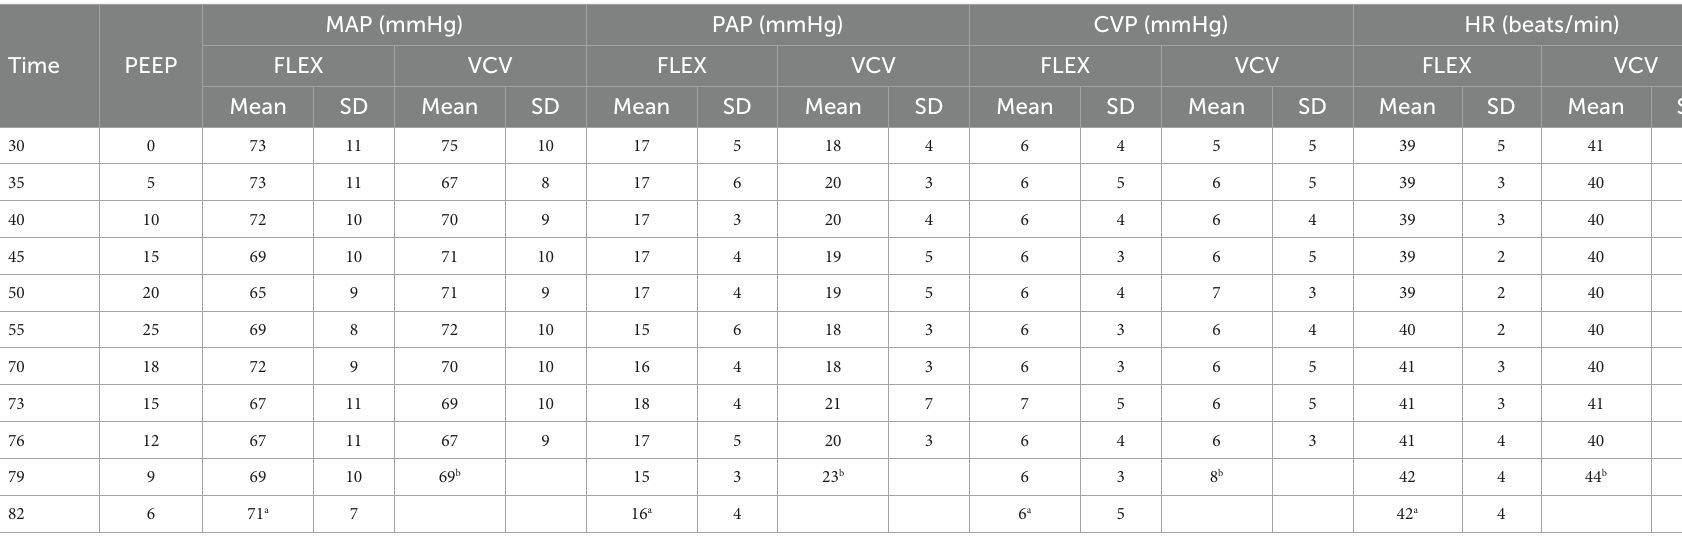
TABLE 1 Mean and standard deviation (SD) of mean arterial blood pressure (MAP), pulmonary artery pressure (PAP), central venous pressure (CVP) and heart rate (HR) of six horses ventilated either with FLEX or conventional volume controlled ventilation (VCV) during PEEP-titration alveolar recruitment; time point 0 min is connection to anesthesia machine.